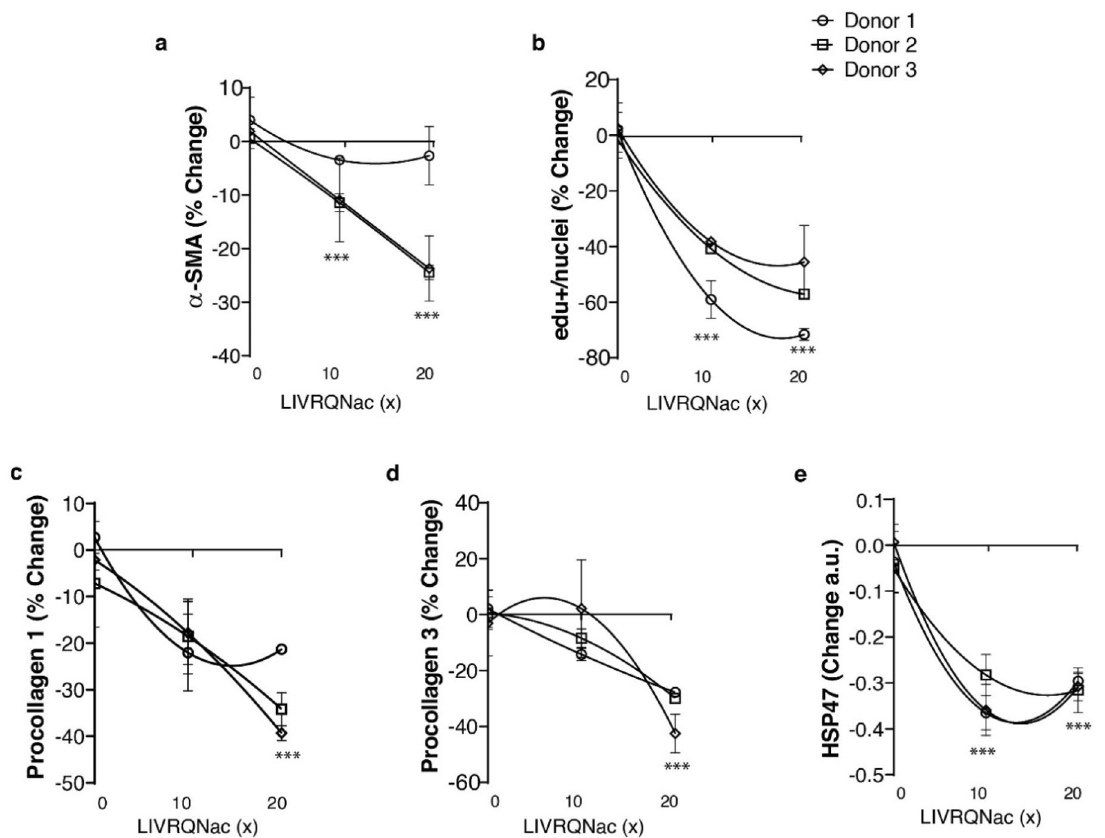
Figure 3. LIVRQNac reduces the induction of fibrogenic markers in TGF-β-treated human hepatic stellate cells. ( a ) α-SMA immunostaining and ( b ) labeled EdU positive intensity quantification from fixed and stained HSCs stimulated with TGF-β1 (3 ng/mL) and treated with either LIVRQNac (10x–20x) or with PBS vehicle (0x) for 24 h. Data is normalized to nuclei count and represented as a mean percentage change relative to TGF-β1- stimulated HSCs (0x) of at least three technical replicates from three independent donors. *** p < 0.001 versus TGF-β1 (0x) for all three donors combined. ( c ) Procollagen 1 and ( d ) procollagen 3 secreted levels measured in HSCs supernatant stimulated with TGF-β1 (3 ng/mL) and treated with either LIVRQNac or with PBS vehicle (0x) for 24 h. Data displayed as percent change relative to TGF-β1-stimulated HSCs (0x) represents the mean of at least three technical replicates from three independent donors. *** p < 0.001 versus TGF-β1 (0x) for all three donors combined. ( e ) HSP47 gene expression measured by qRT-PCR on RNA extracted from HSCs cells stimulated with TGF-β1 (3 ng/mL) and treated with either LIVRQNac (10x–20x) or with PBS vehicle (0x) for 24 h. GAPDH-normalized expression of HSP47 is represented as the mean of relative fold change to TGF-β1-stimulated HSCs (0x) of at least three technical replicates from three independent donors. *** p < 0.001 versus TGF-β1 (0x) for all three donors combined. Note: 0x corresponds to TGF-β1-stimulated HSCs without additional LIVRQNac. Error bars represent ± SEM. LIVRQNac was used at a range of concentrations (10x–20x relative to human plasma concentration for LIVRQ and 2.5 mM and 5 mM Nac; applied 24 h before TGF-β1 stimulation). Analysis was performed using GraphPad Prism version 9.0.1 for Windows, GraphPad Software, San Diego, California USA, www. graph pad. com. The graphs were assembled using Adobe Illustrator CC 2019, www. adobe. com. α-SMA alpha-smooth muscle actin, EdU 5-ethynyl-2 ′ -deoxyuridine, GAPDH glyceraldehyde 3-phosphate dehydrogenase, HSC primary human stellate cell, HSP47 heat shock protein 47, Nac N -acetylcysteine, PBS phosphate-buffered saline, qRT-PCR quantitative reverse transcription-polymerase chain reaction, RNA ribonucleic acid, SEM standard error of mean, TGF-β1 transforming growth factor beta-1, x fold